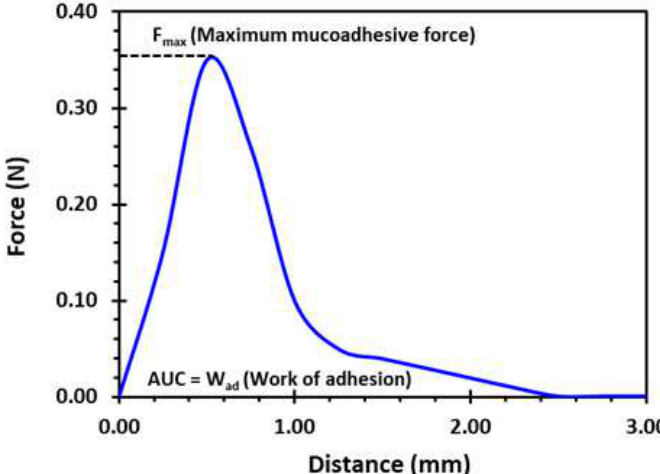
Figure 17. A typical force vs. distance profile for a 3D-printed tablet (F2, (2 shells with 0% infill)) from the mucoadhesion test performed in 0.1 N HCl (150 mL) at 37 °C using the texture analyser. Fmax is the highest force required to separate the probe from the gastric tissue which is determined from the maximum peak height of the profile. Wad is the total force involved in the probe separation during withdrawal phase which is calculated from the area under the curve (AUC) of the force vs. distance profile.